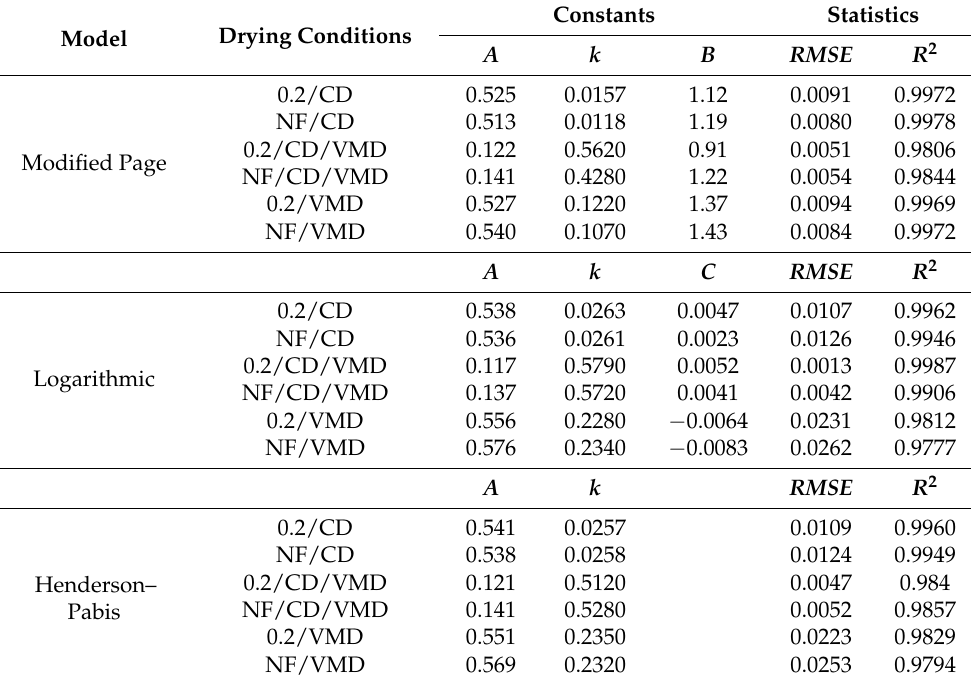
Table 2. Mathematical models used to fit experimental data obtained during drying using different